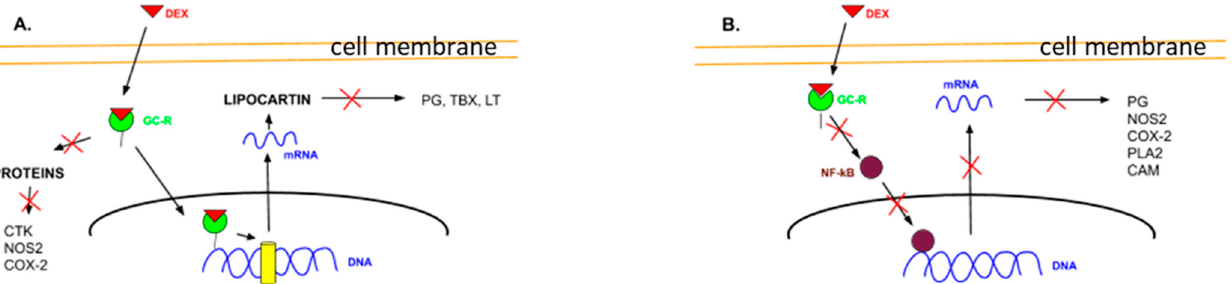
Figure 2. Dexamethasone action models: genomic effect ( A ) and non-genomic effect ( B ) [44]. DEX has good oral bioavailability; it is rapidly and completely absorbed in the gas- trointestinal tract and had an elimination half-life of 1–2 h. After intramuscular injection, DEX sodium phosphate is absorbed slowly, with the maximum plasma